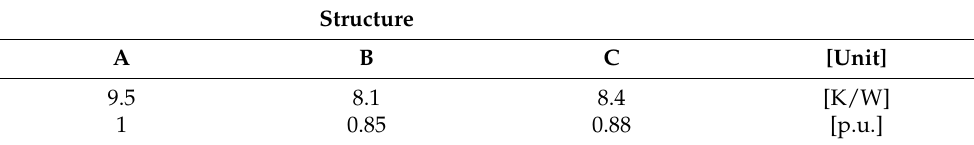
Table 2. Estimates of measured R th based on measurement